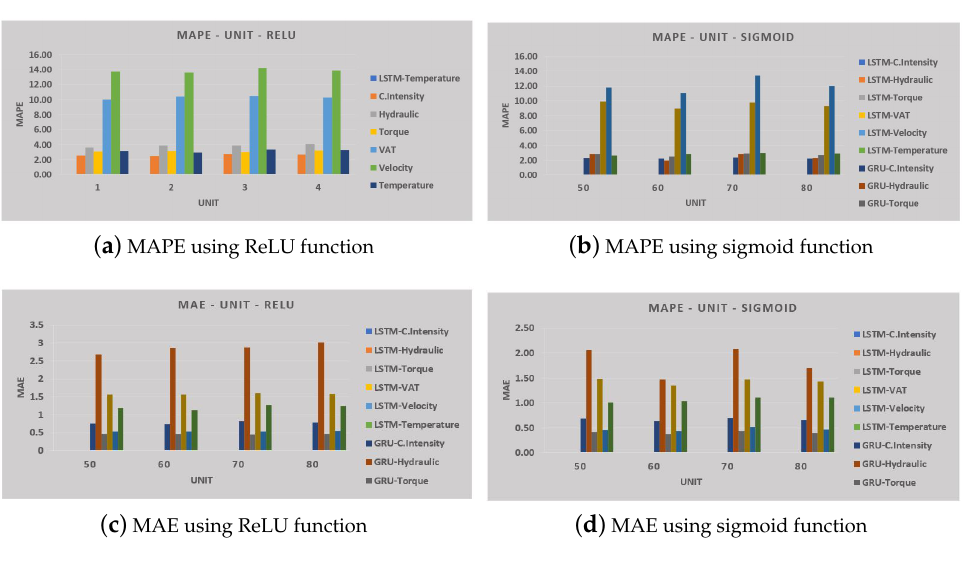
Figure 16. MAPE and MAE obtained with different numbers of units in the hidden layer, measured when predicting future values 30 days in advance, with a resampling period of one hour. The LSTM was not able to learn, so the results are just for the GRU.